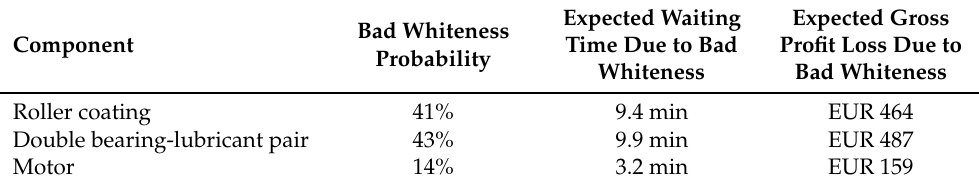
Table 19. Direct failure costs for every failure type of roller coating, double bearing-lubricant pair and motor of the bleaching machine